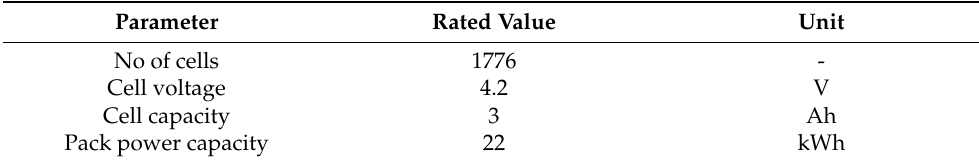
Table 2. Battery pack